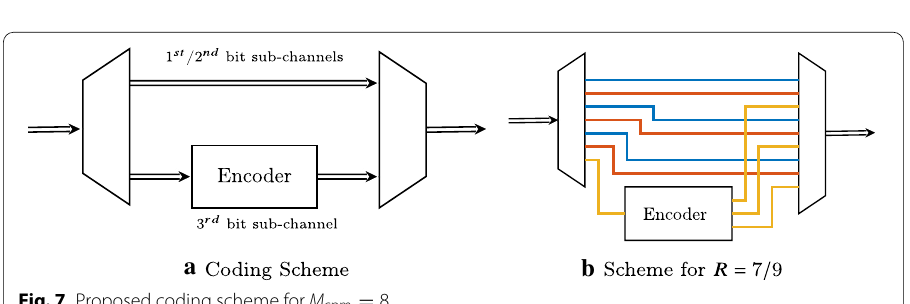
Fig. 7 Proposed coding scheme for M cpm =